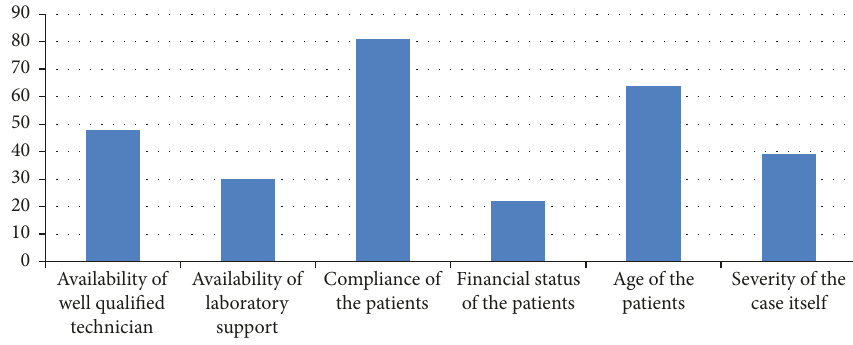
Figure 1: Factors limiting orthodontists’ choice for the removable functional appliance.